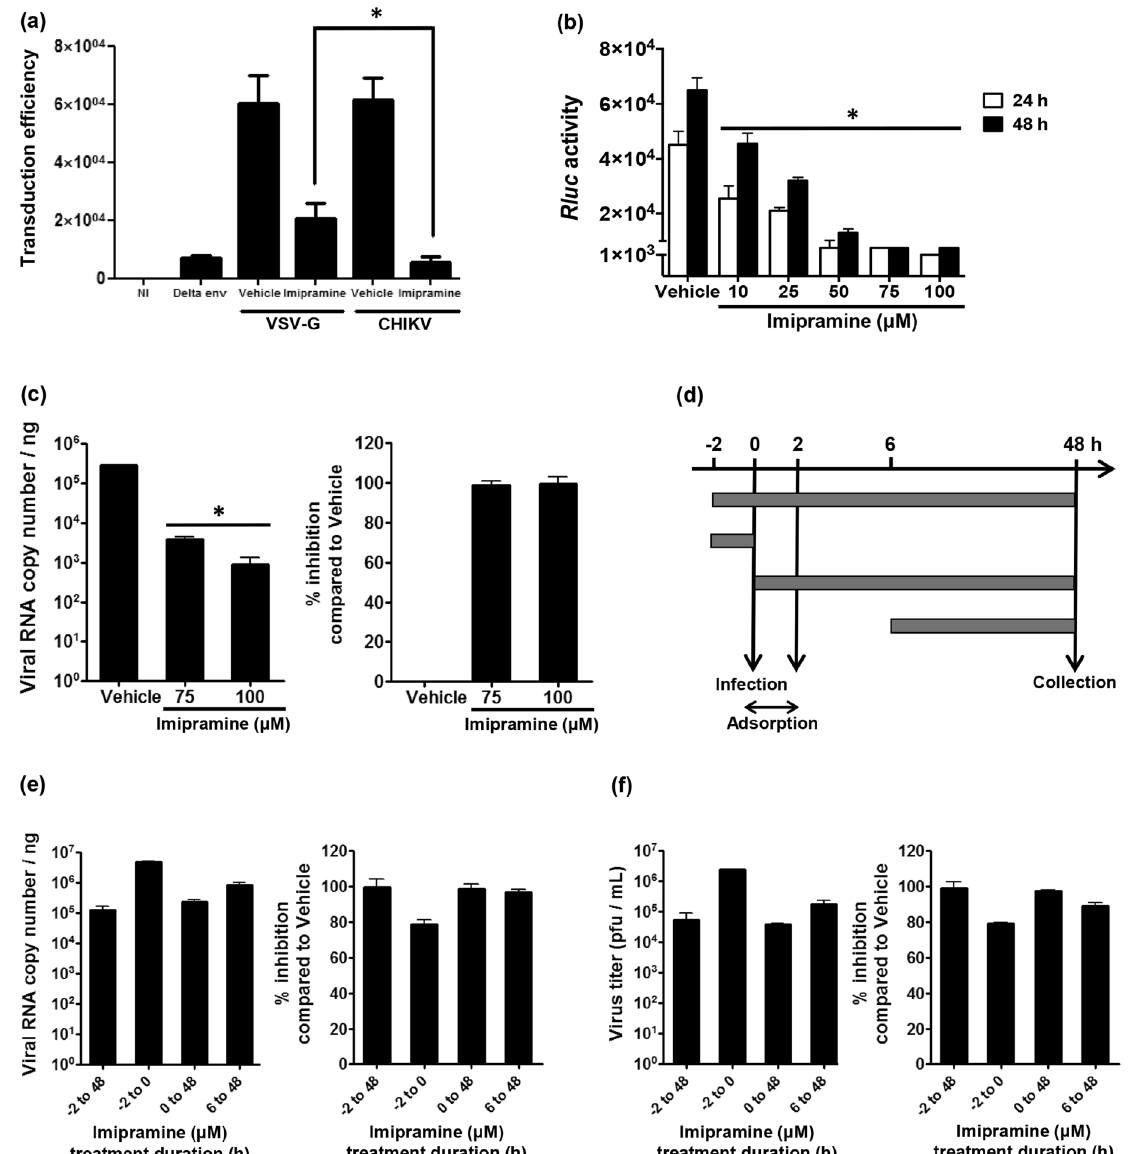
Figure 3. Imipramine exerts its inhibitory effects at different stages of the viral life cycle. ( a ) Human primary skin fibroblasts were either treated with 75 µ M imipramine or with PBS (vehicle) for 24 h and then challenged with CHIKV Env- or VSV-G-pseudotyped HIV particles. HIV particles devoid of envelope were used to monitor potential pseudo-transduction events. Transduction of the cells was monitored by quantification of GFP expression in the cells after 48 h. Values are normalized according to protein contents of the cell extract and correspond to the mean of triplicate ± SD. NI is for non-transduced cells. * p < 0.05. ( b ) Stable transfected Huh-7 cells with CHIKV-NCT replicon were treated with different concentrations of imipramine. After 24 and 48 h, treated cells were measured for the Renilla Luciferase ( Rluc ) activity. Vehicle–treated (PBS) cells were used as control (“0”) concentration. Relative Rluc activity expressed by the CHIKV replicon represents CHIKV’s RNA replication. Values are normalized according to protein contents of the cell extract and correspond to the mean of triplicate ± SD. ( c ) Results of RT-PCR analysis of viral RNA copy numbers in vehicle and imipramine treated cells. Percentage of inhibition (right panel) is calculated as described for Fig. 1. The data represent mean ± SD from three independent experiments. * p < 0.05 when compared to cells treated with vehicle. ( d ) Schematic presentation of the time-of-addition assay. Human skin fibroblasts, treated as shown with 10 µ M, 25 µ M, 50 µ M, 75 µ M or 100 µ M of imipramine, were infected with CHIKV La Réunion strain for 48 h. ( e ) Inhibition of virus RNA synthesis by 75 µ M of imipramine was quantified using real time RT-PCR. Viral RNA copy numbers, obtained under different conditions, are shown on the left panel; right panel shows achieved percentage of inhibition calculated as for Fig. 1. ( f ) Inhibition of infectious virus production by 75 µ M of imipramine was analyzed using plaque assay. Virus titers, obtained under different conditions, are shown on the left panel; right panel shows achieved percentage of inhibition calculated as for Fig. 1. Data for all used concentrations is shown on Supplemental Figs S4 and